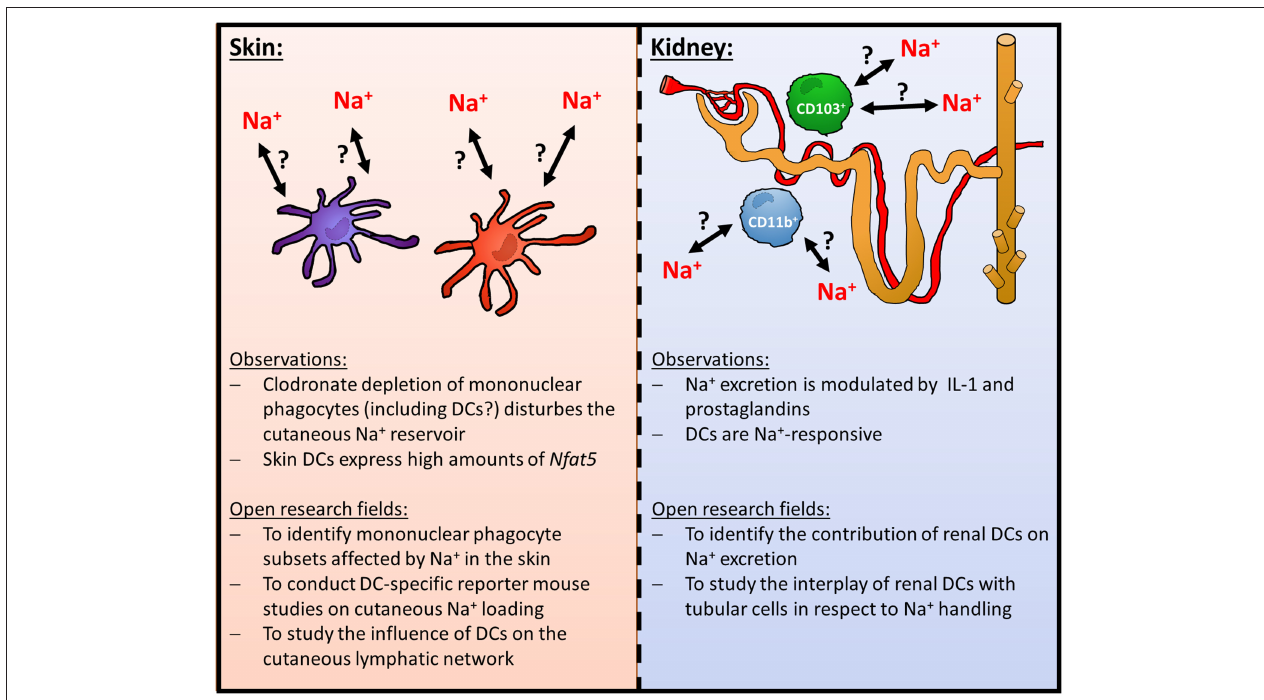
FIGURE 1 | Role of DCs in homeostatic cutaneous and renal Na +